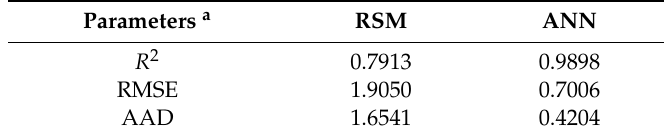
Table 5. Comparison of optimization and prediction capabilities of ANN and response surface methodology (RSM) for CGA extraction.